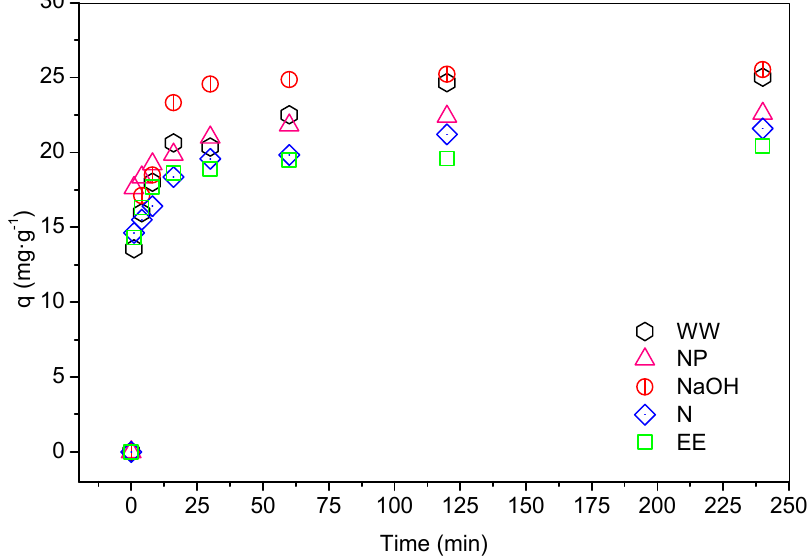
Figure 1. Adsorption kinetics of the five types of adsorbents tested for the removal of Pb(II) ions. Test conditions: 24–25 °C, pH 5.5 to 5.8, 102 mg·L −1 , 100 rpm and 0.1 g of adsorbent.